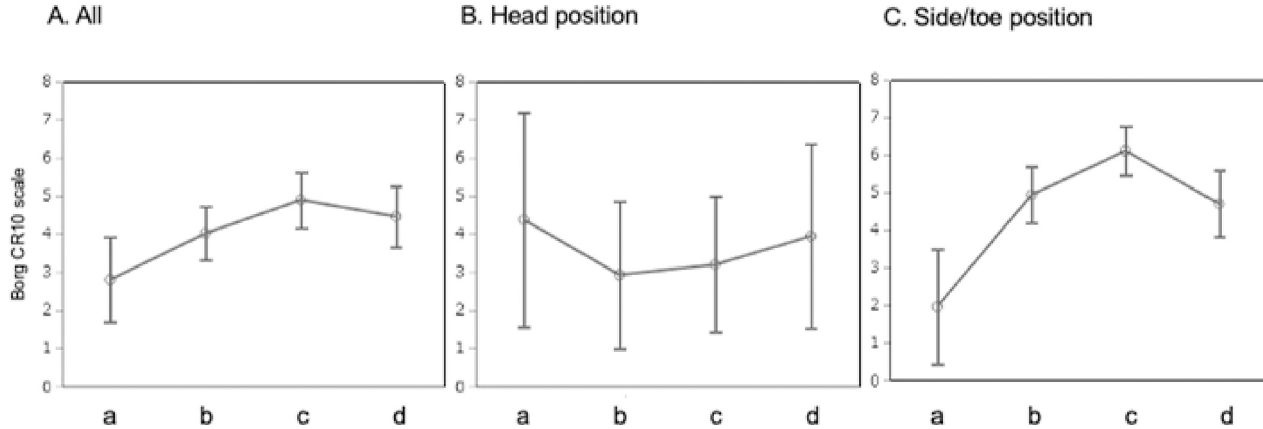
Fig 3. The Borg CR10 scale after adjustment for other factors. a: The Airstretcher with dragging, b: The Airstretcher with lifting, c: The Backboard with lifting, d: The Tarpaulin with lifting.